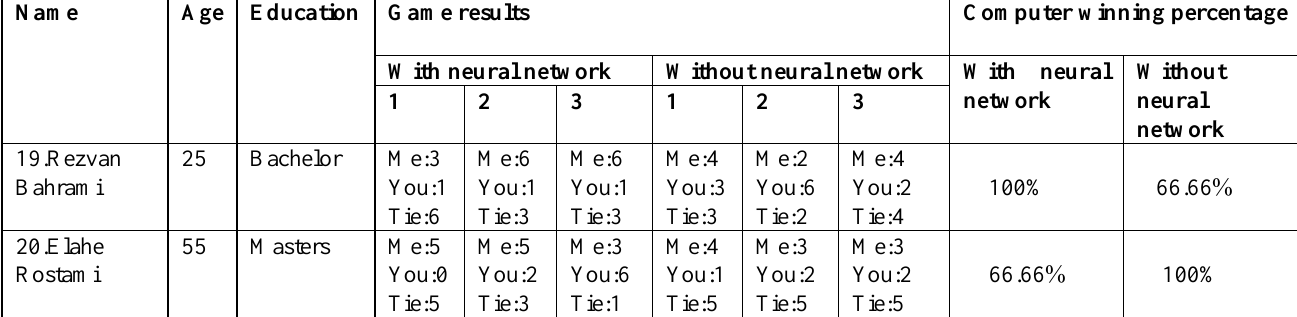
(continued). Game results and computer winning percentage in women with and without the neural